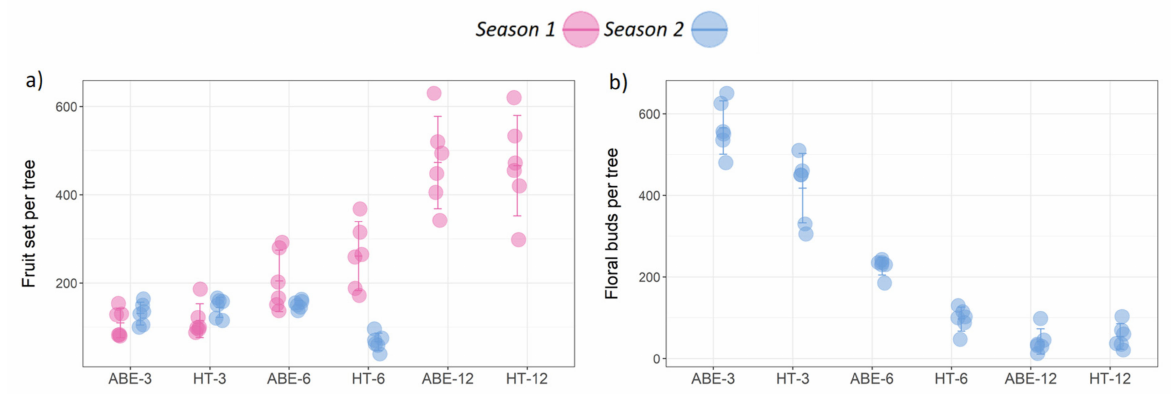
Figure 1. Effect of thinning regime and crop load on ( a ) fruit set across two seasons, and ( b ) return bloom during the second season (error bars represent 95% confidence interval). ABE = artificial bud extinction; HT = hand